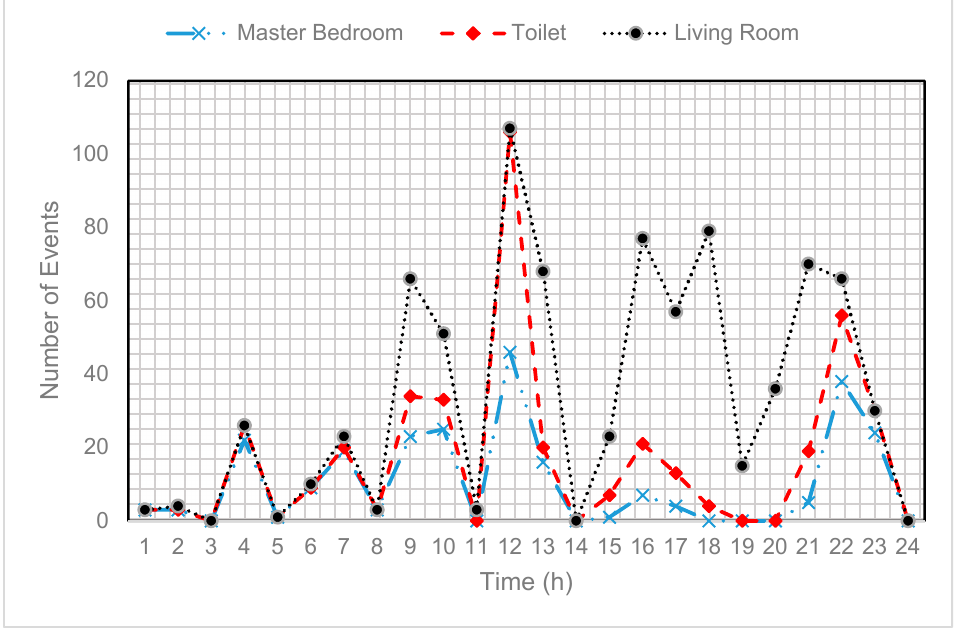
Figure 6. Several activities performed by the smart home resident in the master bedroom, toilet, and living room.